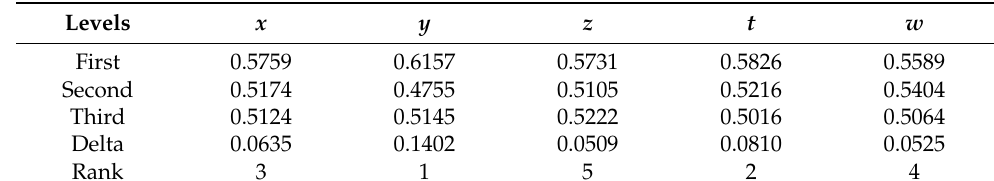
Table 6. Outcomes of analyzing mean values.